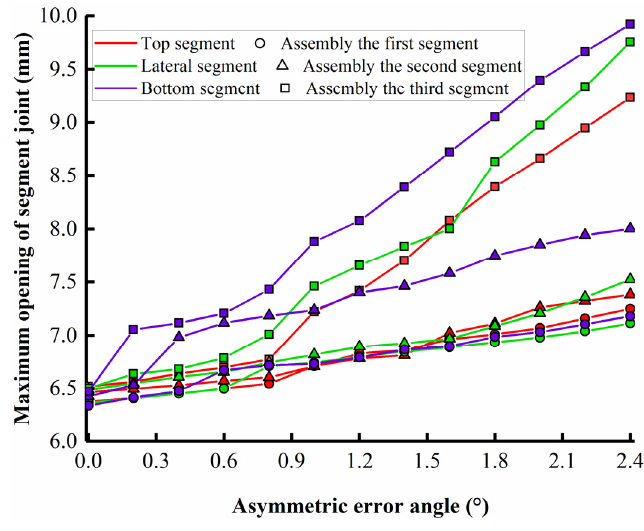
Figure 20. Maximum compression damage factor in the presence of lateral deflection.